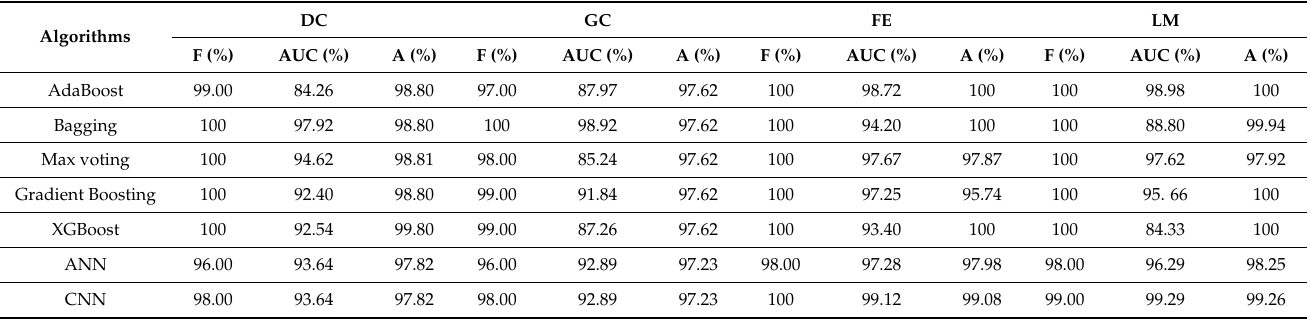
Table 12. Comparison Performance between Five Ensemble and Two Deep Learning Methods code smells